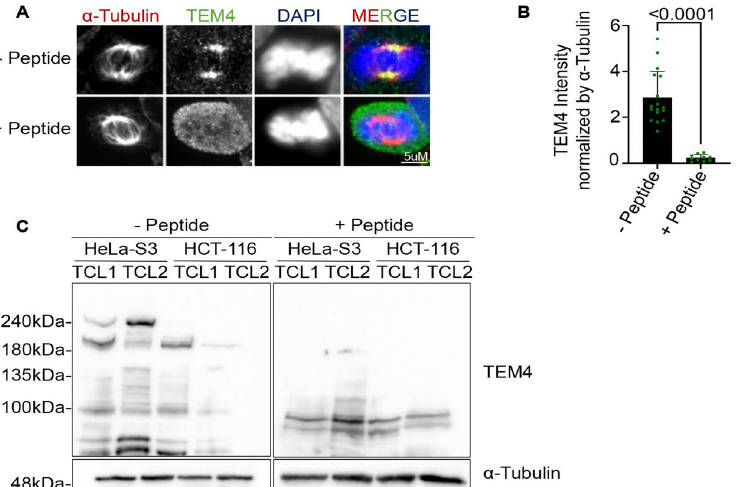
Fig 2. A peptide competition assay confirms reactivity of the TEM4 antibody to the mitotic spindle. A: TEM4 blocking peptide competition assay in HCT-116 cells. Cells synchronized in mitosis after 10 hours of release from a double thymidine block and fixed for 10 minutes with PTEMF buffer. TEM4 antibody (1 μ g) was pre-incubated with either vehicle control (top panel) or with the immunogenic peptide (20 μ g) corresponding to the 18 amino acid epitopes within the 910–960 residues of TEM4 (bottom panel). Cells were stained with anti-TEM4 (green), anti- α - tubulin for the spindle microtubules (red) and and DNA is stained with HOECHST (blue). Scale bar = 5 μ m. B: Statistical analysis of TEM4 intensity at the mitotic spindle incubated either with vehicle control or with the immunogenic TEM4 peptide from A. The experiment was performed in one biological replicate and the P value is calculated based on the mean SD of cells per condition. C: Immunoblots of HeLa S3 or HCT-116 cell lines. Total cell lysates from both cell lines were extracted with RIPA buffer and run on a polyacrylamide gel. Western blot was performed with either TEM4 (1 μ g) antibody incubated with vehicle control (left panel) or with the immunogenic TEM4 peptide (20 μ g) (right panel).